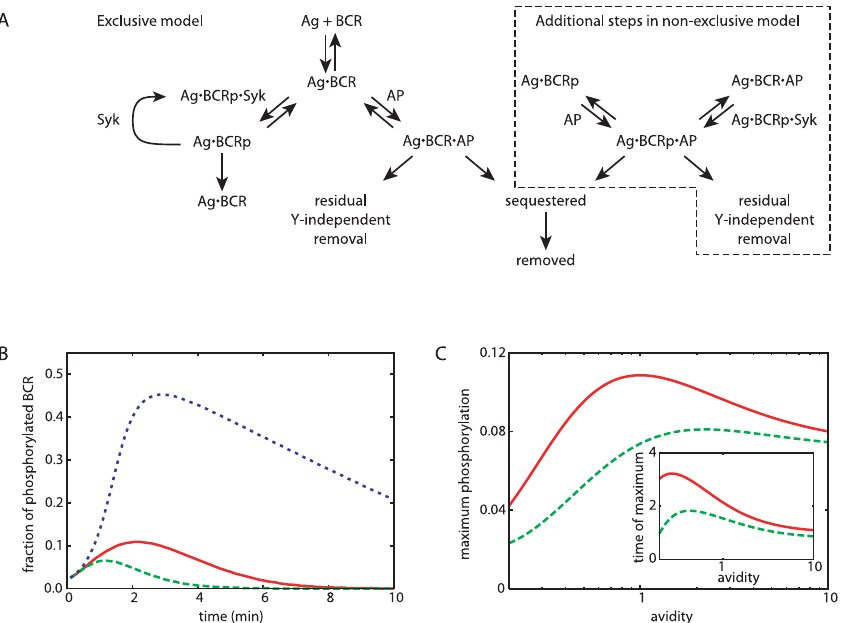
Figure 6. Mathematical Analysis of Interrelationships between Antigen Receptor Signaling and Internalization (A) Schematic representation of the exclusive and independent models of BCR phosphorylation and internalization. The independent model includes all the reactions in the exclusive model plus the additional ones indicated. Eliminating the sequestration reaction corresponds to clathrin deletion while eliminating the removal reaction corresponds to dn-dynamin (see discussion). (B) Extent of phosphorylation for wild-type (red), dn-dynamin (green), and clathrin mutant scenarios (blue). (C) Maximal signaling through the BCR, as assayed by Ig a phosphorylation, as a function of ligand avidity. A comparison of exclusive (red) and independent (green) signaling and internalization models is provided (inset). Time to maximum BCR signal intensity as a function of ligand avidity as predicted for the exclusive (red) and independent (green) models. The parameters used to generate the figure are k off ¼ 2.0 min (cid:1) 1 , k þ a ¼ k –a ¼ 4.0 min (cid:1) 1 , k þ s ¼ 8.0 min (cid:1) 1 , k –s ¼ 4.0 min (cid:1) 1 , k p ¼ 10.0 min (cid:1) 1 , k r ¼ 5.0 min (cid:1) 1 , k c ¼ 4.0 min (cid:1) 1 , k d ¼ 2.0 min (cid:1) 1 , and k g ¼ 2.0 min (cid:1) 1 ; K i ¼ K M ¼ 0.1 in units such that the initial BCR concentration is unity. The rate parameters were selected to give for the wild-type a maximum phosphorylation of about 10% at 2–3 min and decay on the order of 10 min. In the case of the non-exclusive model,